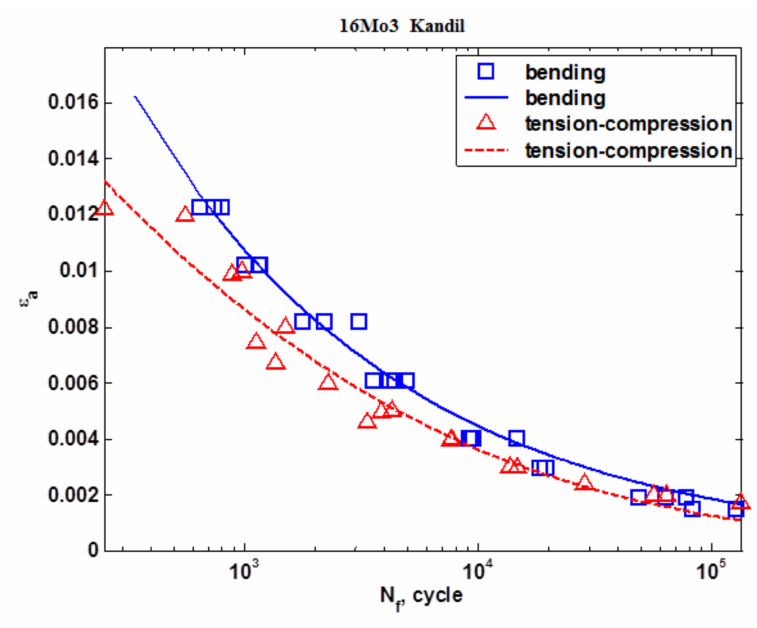
Figure 9. The strain characteristic according to the Kandil